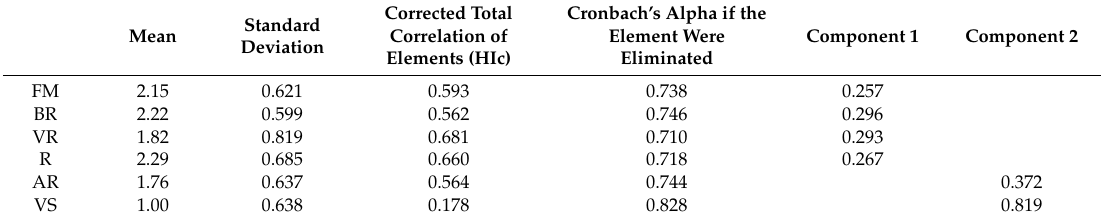
Table 2. Descriptive statistics, internal consistency, and matrix of components of the exploratory factor